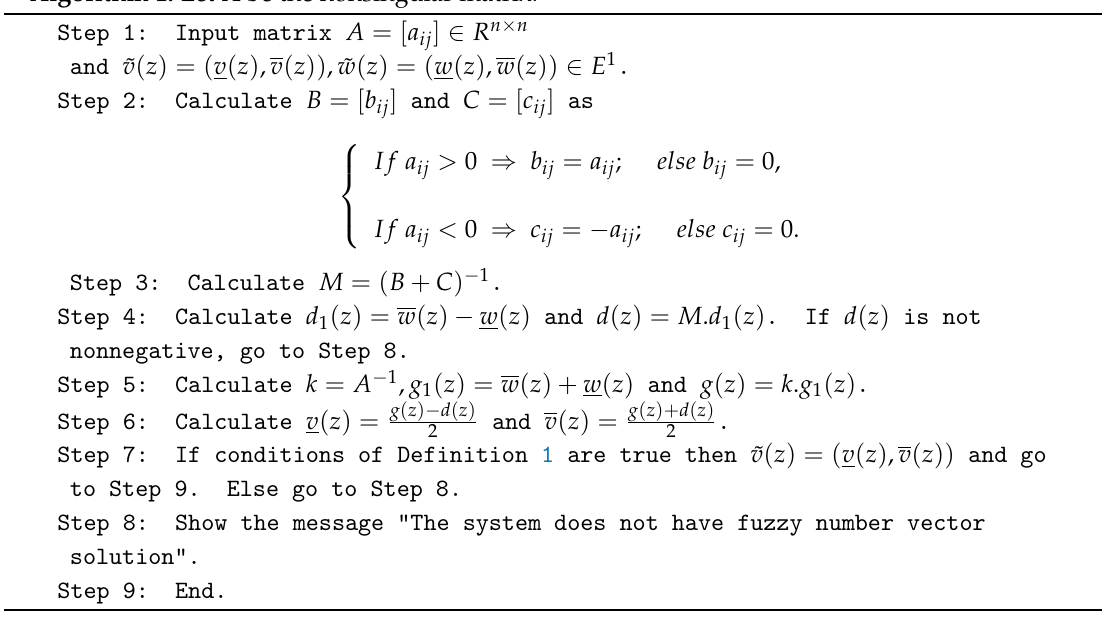
Algorithm 1: Let A be the nonsingular matrix.